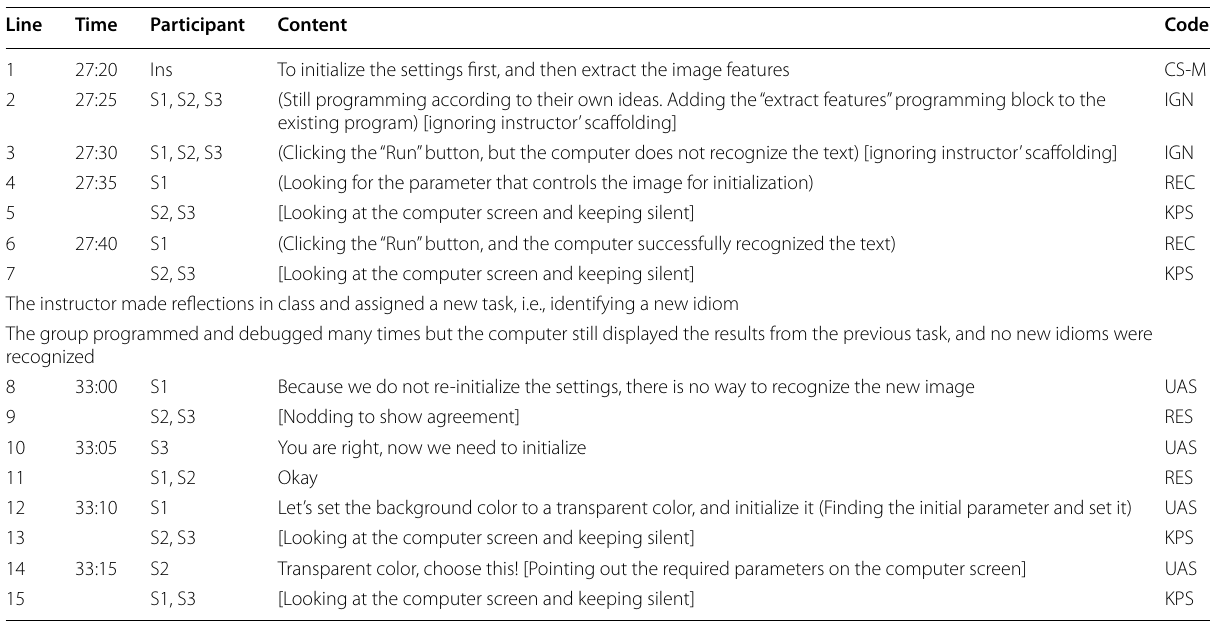
Table 6 The exemplified fragment of Group 7’s delayed use of the CS-M